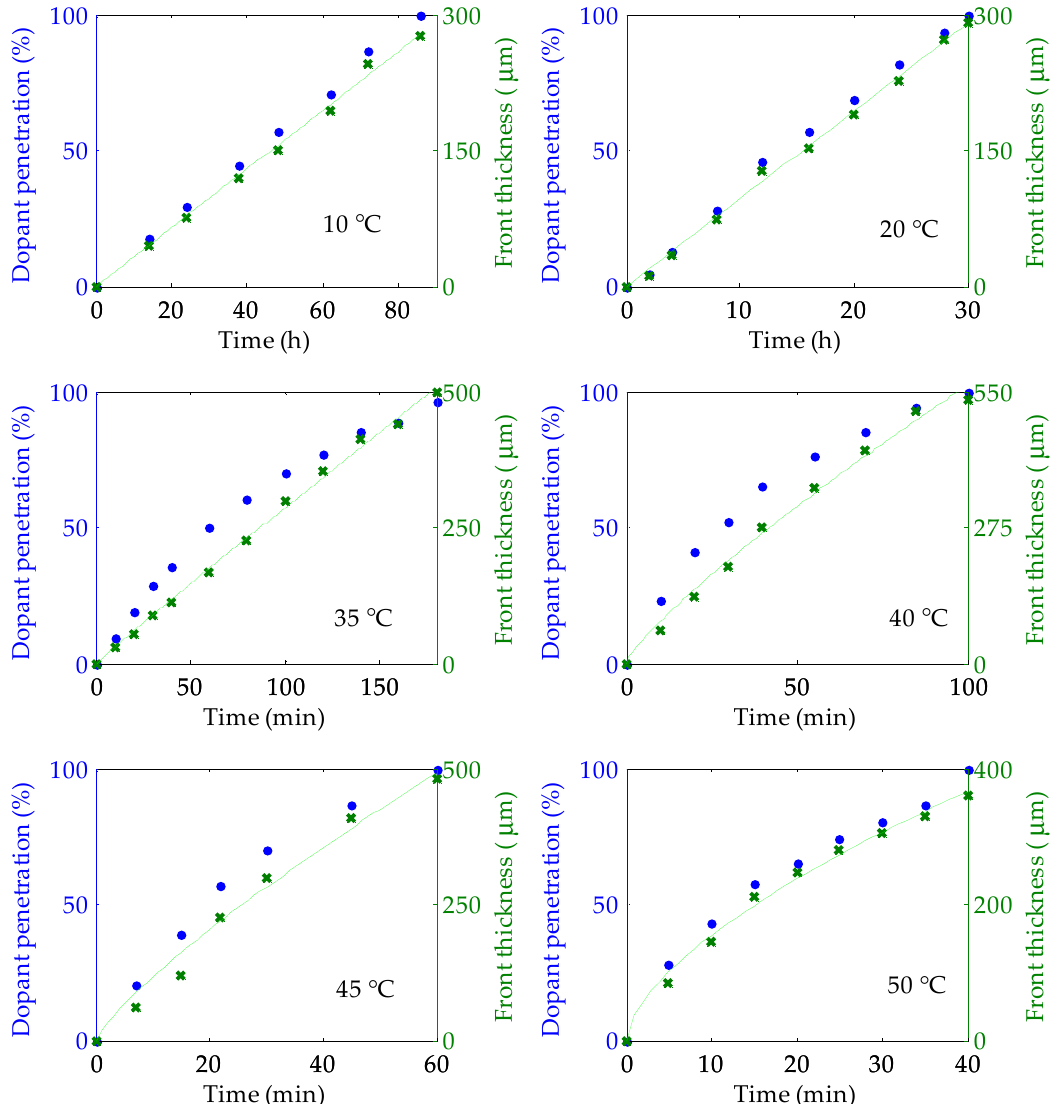
Figure 3. Temporal evolutions of the relative dopant penetration (blue circles) and of the ring’s front thickness (green crosses) for six different doping temperatures: 10 °C, 20 °C, 35 °C, 40 °C, 45 °C and 50 °C. The green lines are the fittings of the front thicknesses at each temperature to Equation (1).